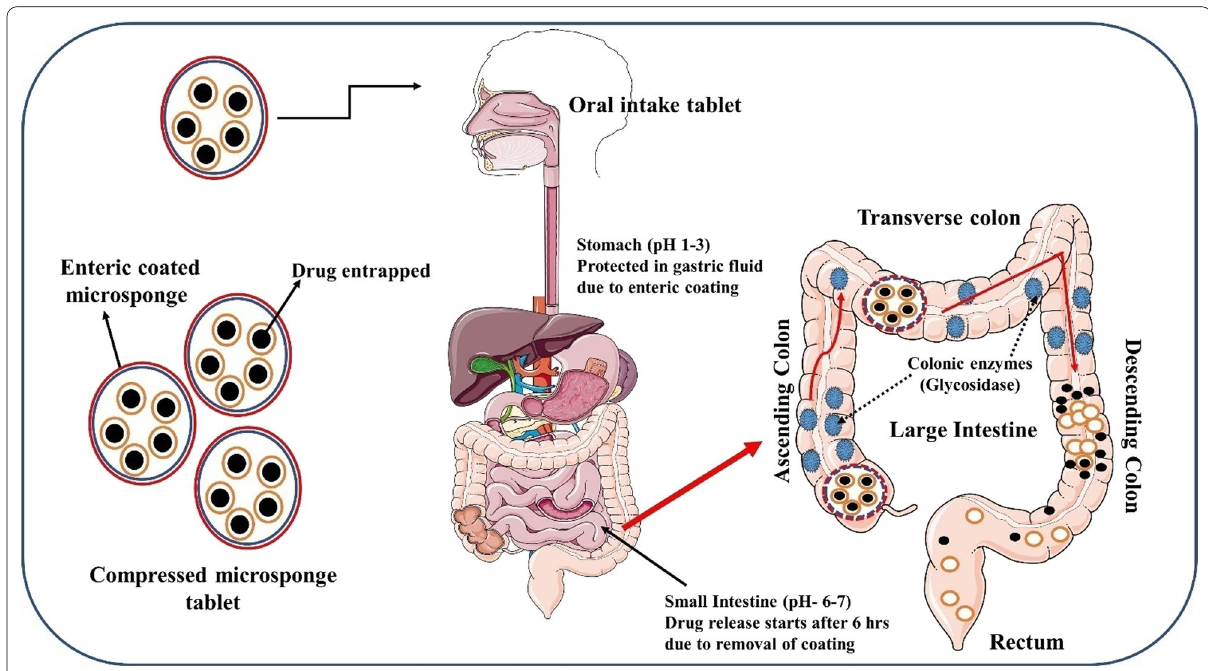
Fig. 9 Drug release mechanisms from microsponges for an oral drug delivery system